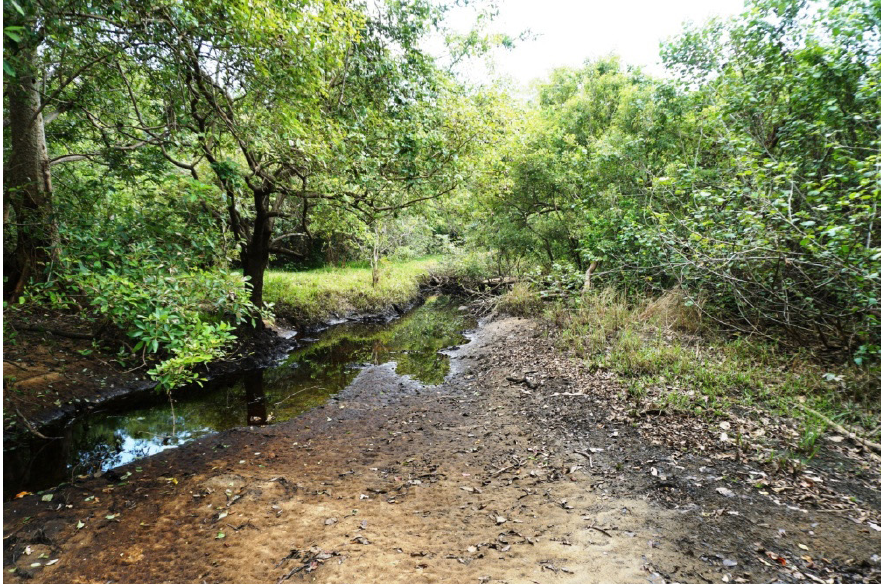
Figure 2: Deep within Somawathiya: Ruins of a nearly thousand year-old irrigation canal, now breached, dispersed, sand-filled and meandering in the forest and with sporadic pools of water (in dry season). The presence of water, before and after the canal was abandoned, possibly over 700 years ago, has induced the development of a wet forest, Dry Canal-associated Evergreen Forest , a newly recognized forest type in Sri Lanka.